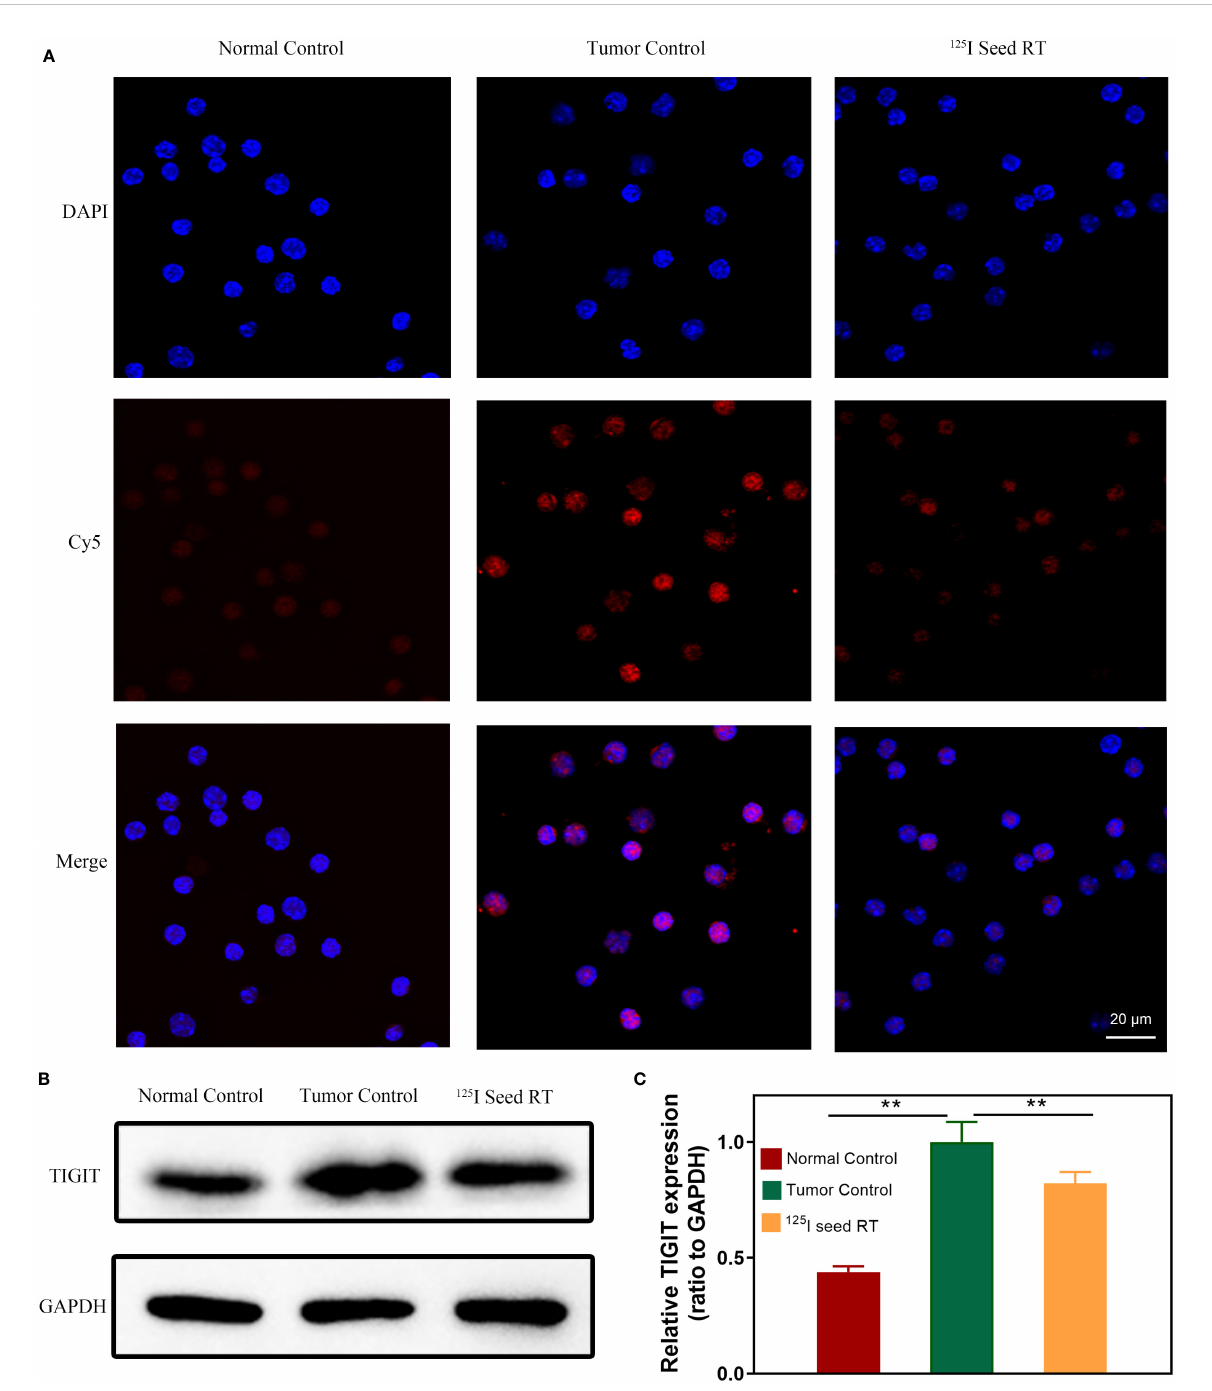
FIGURE 6 TIGIT expression and cellular uptake of probes in lymphocytes. (A) Confocal microscopic imaging of the cellular binding of probes in lymphocytes. (B) Western blotting of TIGIT protein in lymphocytes and (C) quanti fi cation of TIGIT expression (n=3). Scale bar: 20 m m. ** P <